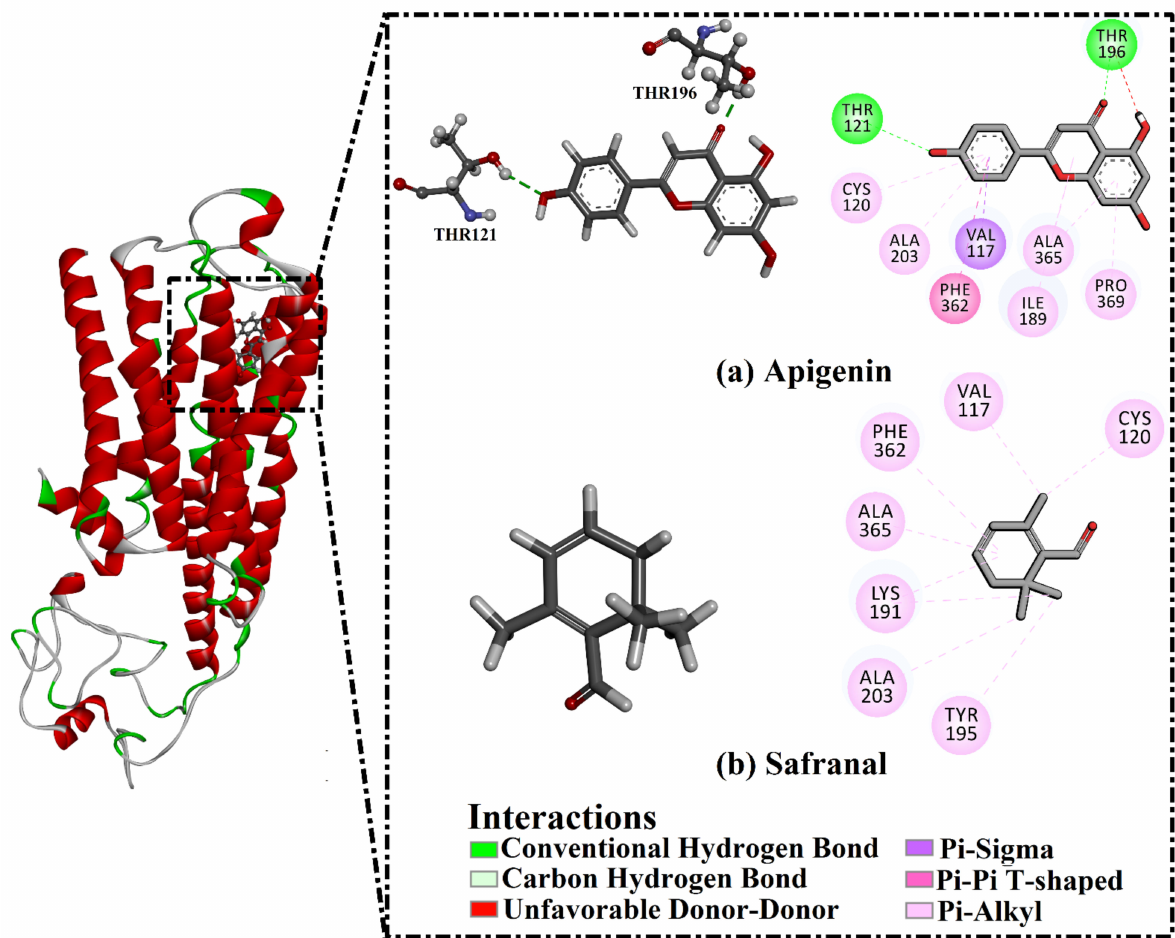
Figure 4. The predicted binding modes of ( a ) apigenin and ( b ) safranal with the 5HT1AR, in accordance with the last trajectory of the 200 ns MD